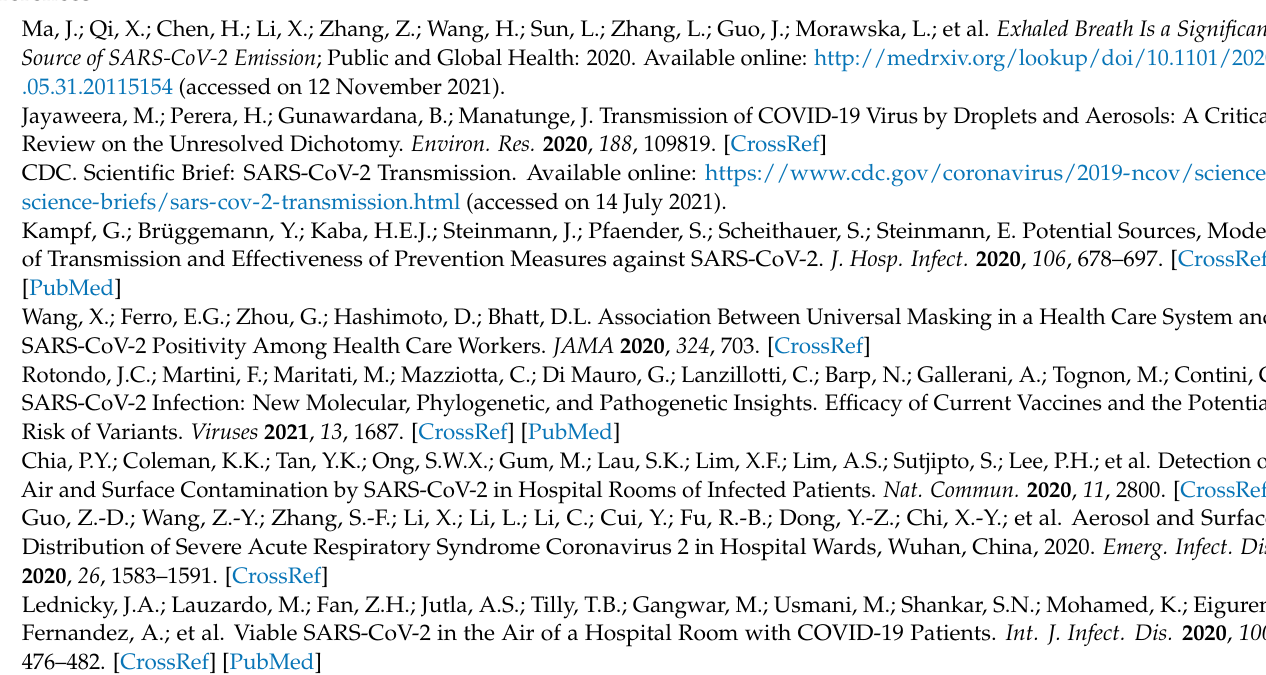
Figure A1. Locations of the aerosol samplers in patient rooms.